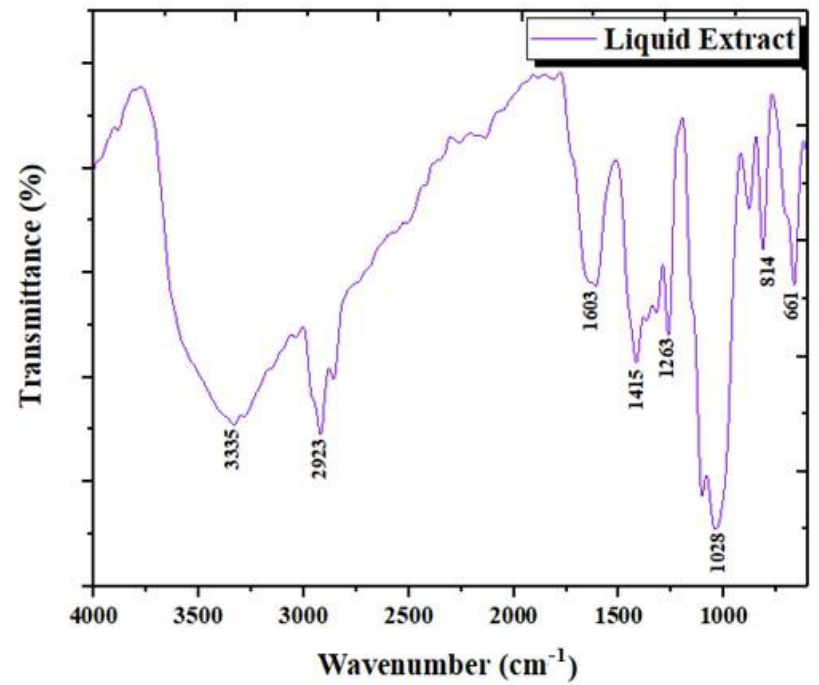
Figure 6. ATR FT-IR spectrum of CB deproteinization liquid extract